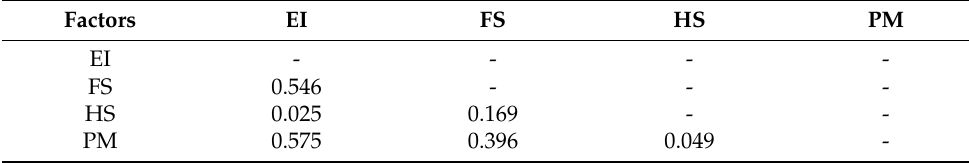
Table 5. Discriminant